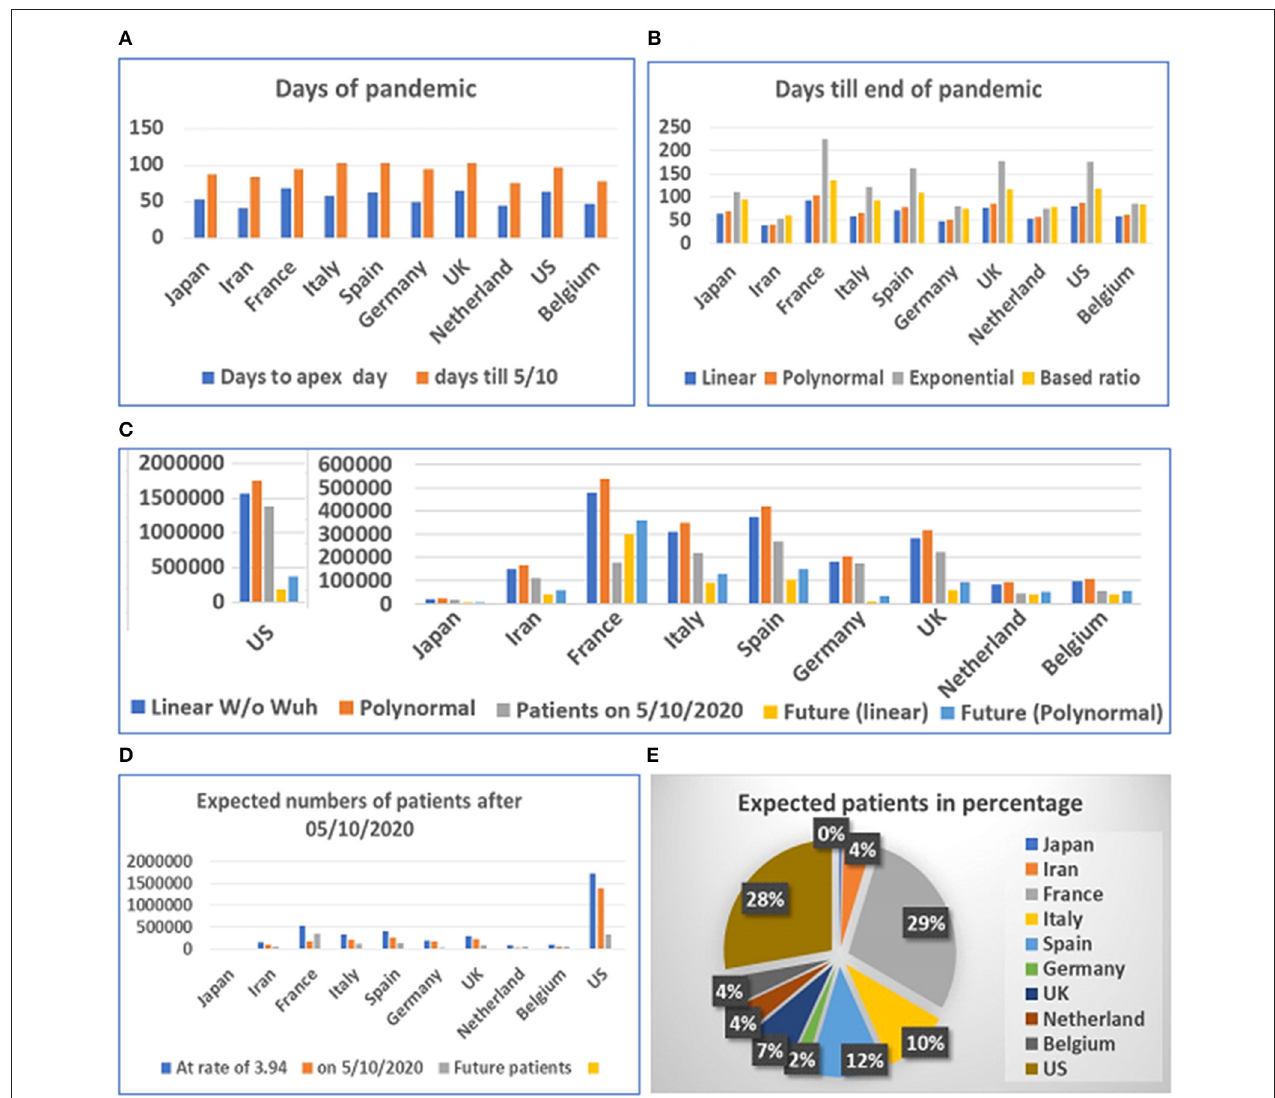
FIGURE 4 | Days and number of patients predicted after May 1, 2020 in 10 countries. (A) Days of pandemic from beginning to apex day and to May 1, 2020. (B) Days remaining before end of pandemic predicted with different models. (C) Future numbers of patients after May 10, 2020, predicted by linear model (W/O data from Wuhan) and polynomal model. (D) Proportions of expected patients in different countries based on calculated ratio before and after apex day from data from China, Switzerland, and South Korea. (E) Proportion of expected patients in different